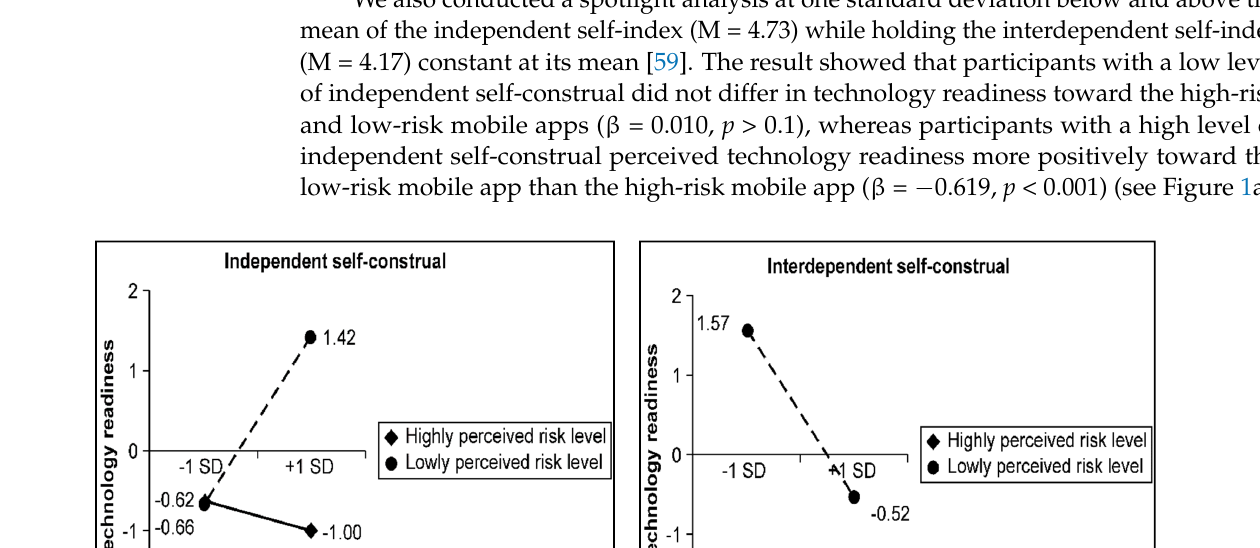
8 Table 4. Results of technology readiness regression analysis on different self-construals and per- ceived risk level. Model